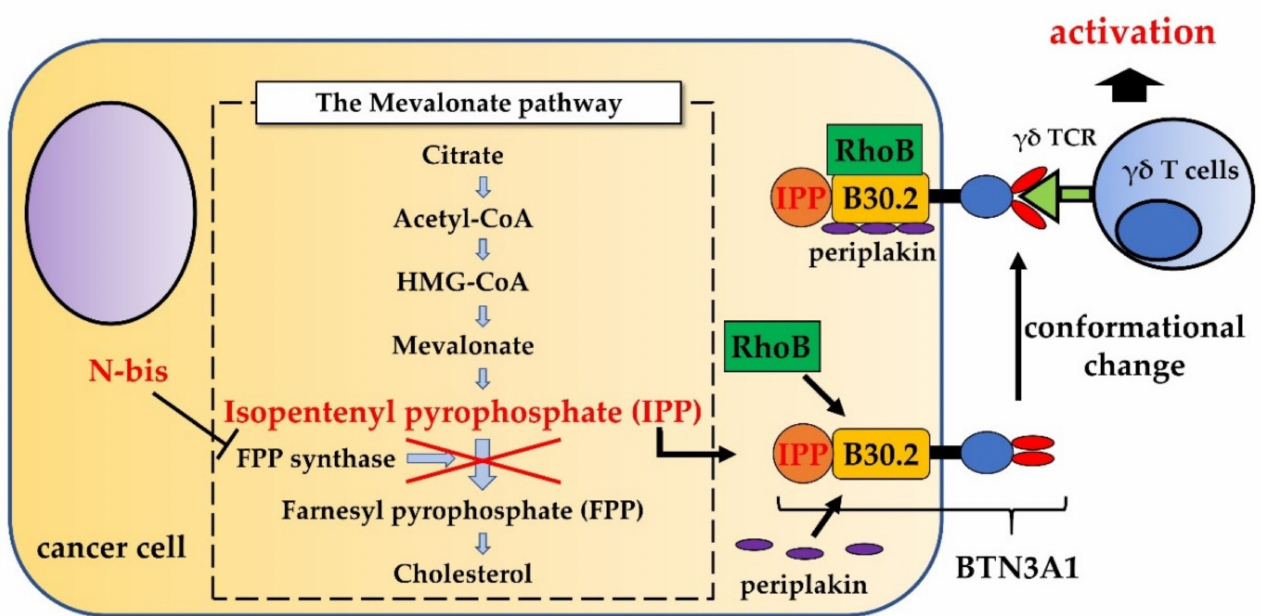
Figure 1. Mechanism of γδ T cell activation by N-bis. N-bis inhibits FPP synthase in the mevalonate pathway and induces accumulation of IPP. Binding of IPP to the intracellular B30.2 domain of BTN3A1 recruits the cytoskeletal adaptor protein periplakin and the GTPase RhoB, which increases membrane mobility and induces a conformational change in BTN3A1, which is then recognized by the γδ